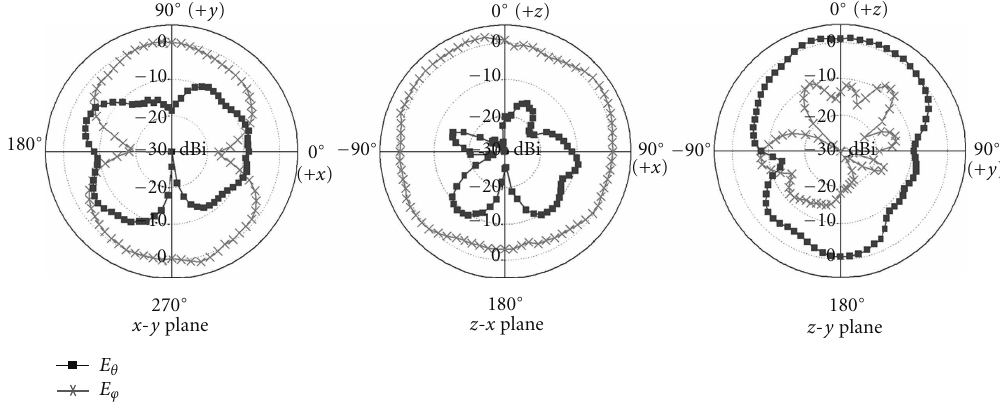
Figure 11: Measured radiation patterns of the hybrid slot antenna.